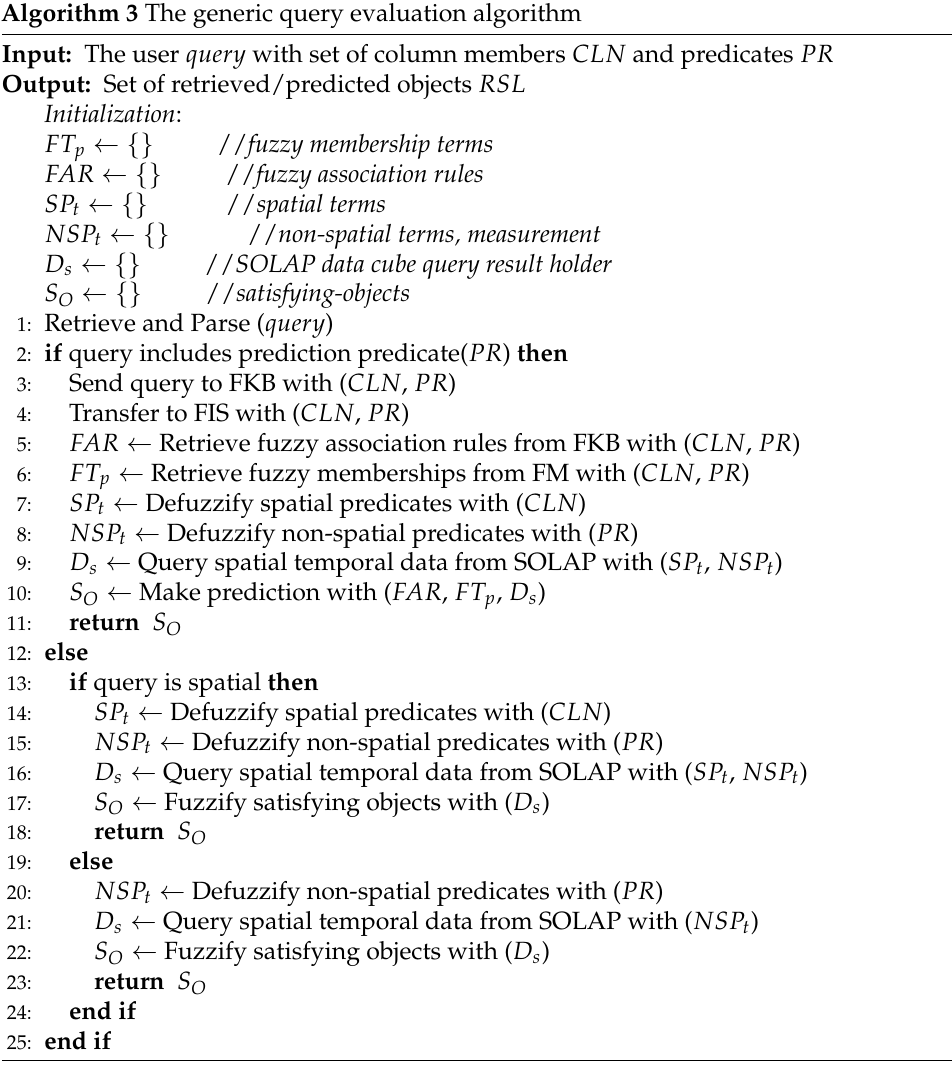
Algorithm 3 The generic query evaluation